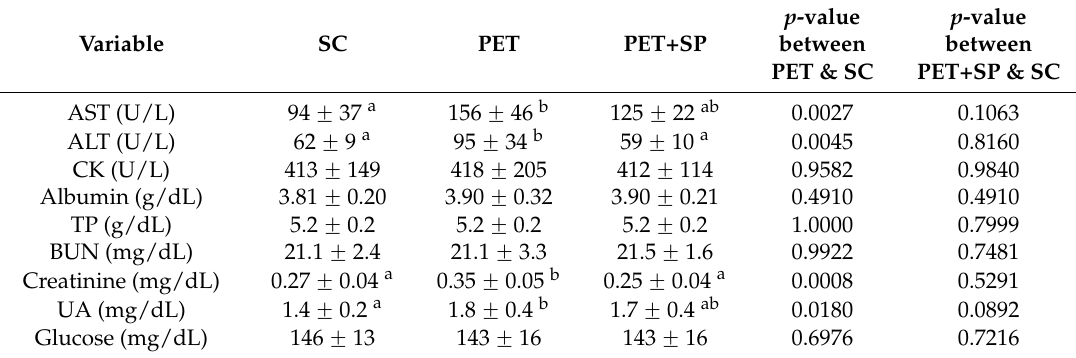
Table 3. Effect of SP supplementation and 4-week PET on biochemical serum levels at the end of the experiment.